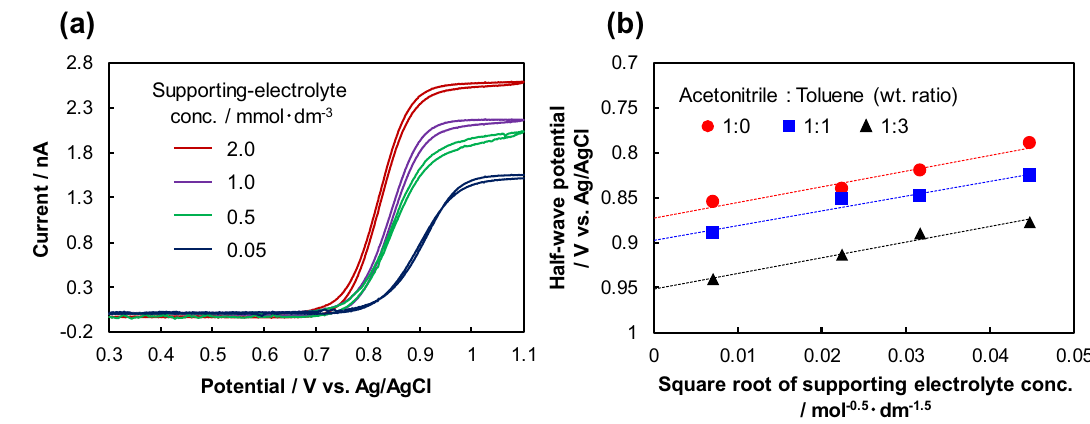
Figure 5. ( a ) Cyclic voltammograms of TPA at various supporting electrolyte concentrations with acetonitrile:toluene weight ratio of 1:1 in the electrolyte. ( b ) Dependence of half-wave potential of TPA oxidation on the concentration of the supporting electrolyte at various acetonitrile:toluene weight ratios in the electrolyte.